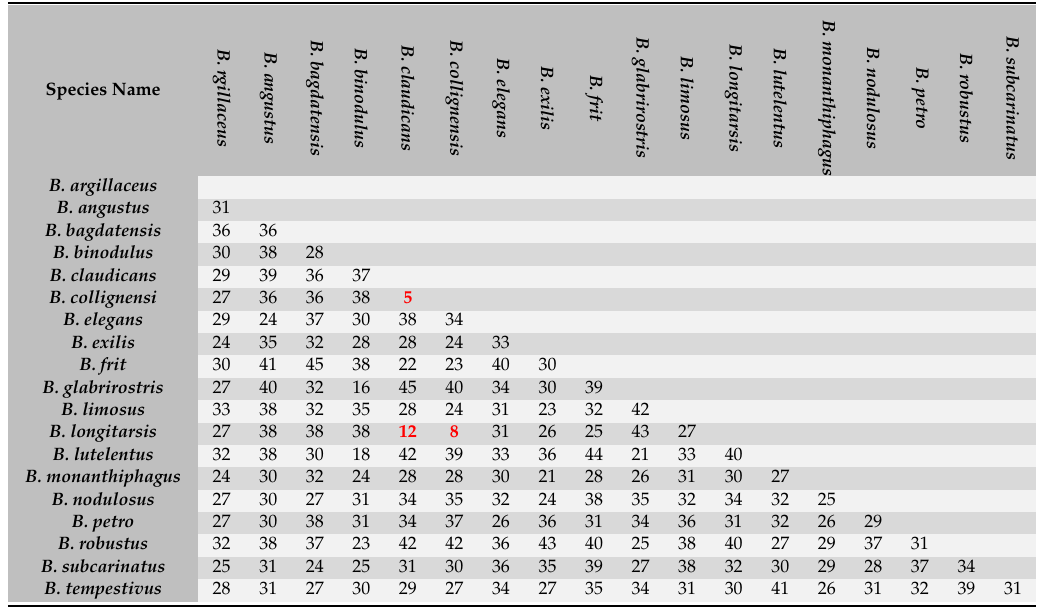
Figure 7. Phylogenetic tree of Bagous species inferred from maximum likelihood (ML) and Bayesian inference (BI) analyses of cytochrome oxidase I ( COI ) gene sequences. The first number on branch is bootstrap support from PhyML and the second is posterior probabilities from MrBayes. Bagous claudicans larva is marked..Codes after the species name are GenBank Accession Numbers. Scale bar unit: expected substitutions per site. Insert shows the dorsal habitus of an imago of Bagous claudicans . Table 1. Mean genetic distances (%) between included Bagous species. Genetic distances based on a GTR + I + G model of DNA evolution. Species from the Bagous claudicans -group in bold, red font.